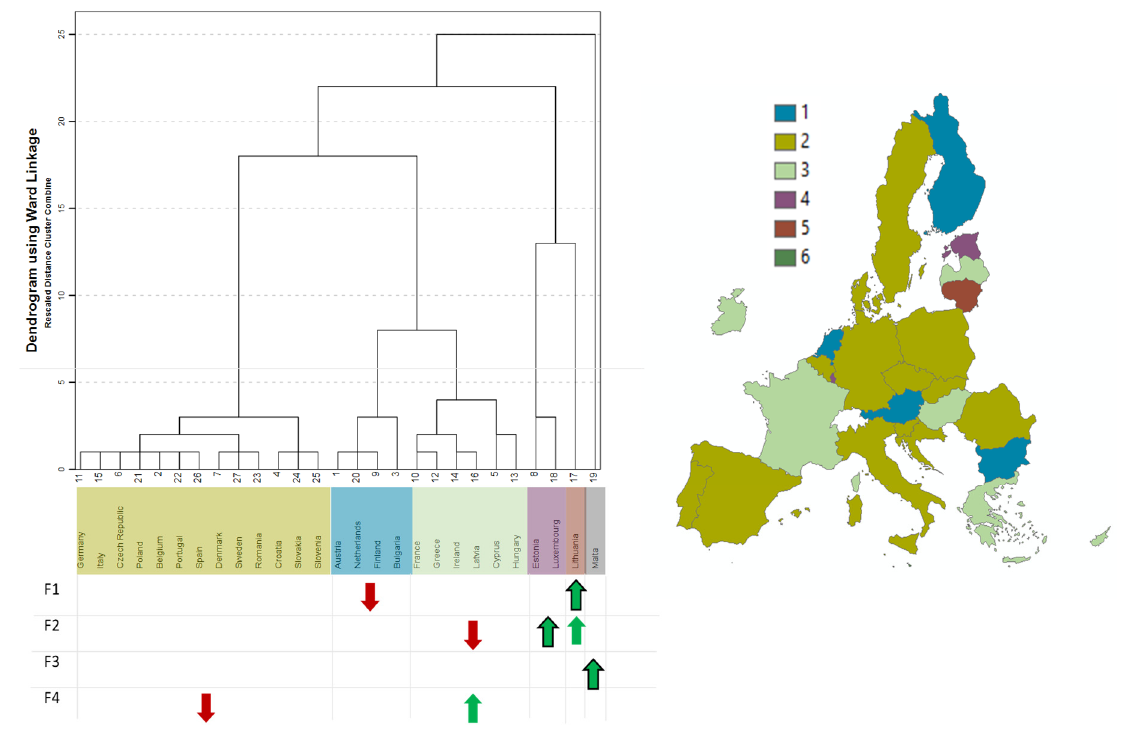
Figure A2. Geographic representation of the scores of the factors.